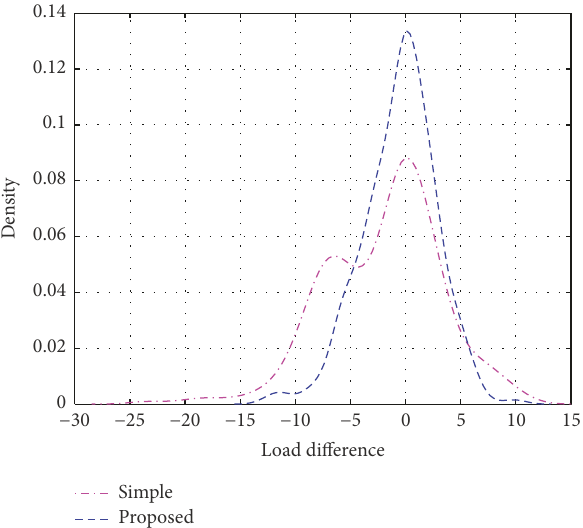
Figure 3: Distributions of the difference of the estimated and true